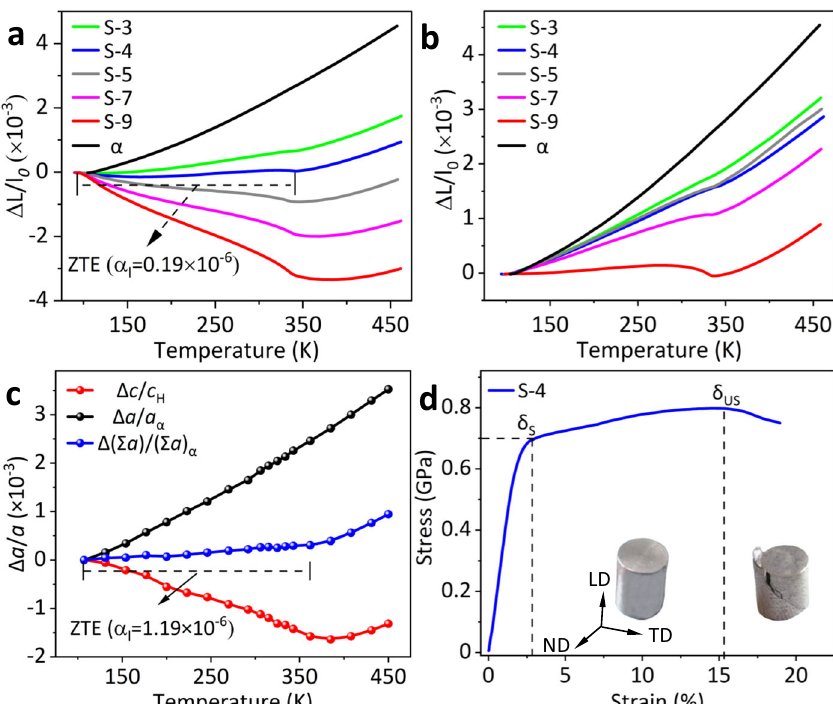
Fig. 3 Thermal expansion and mechanical properties. a Linear thermal expansion determined by advanced thermo-dilatometer for S-3 to S-9 and iron along with LD. b The in-plane (TD-ND) linear thermal expansion of S-3 to S-9 and iron. c Lattice thermal expansions of α along the a axis, H along the c axis, and S-4 along with LD. d Compressive stress-strain curves of the S-4 with the insets of S-4 ingot during